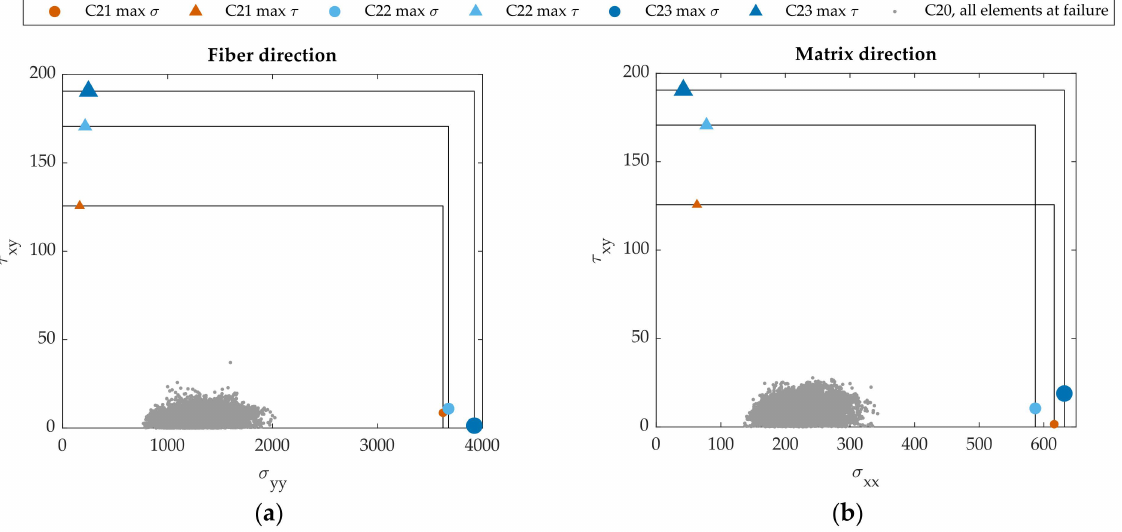
Figure 9. Plots of the stress state values at the most heavily loaded elements at failure on ( a ) the σ yy - τ xy plane (fiber direction in the material); ( b ) the σ xx - τ xy plane (matrix direction in the material). The grey cloud contains all stress states of the elements in the plain specimen at